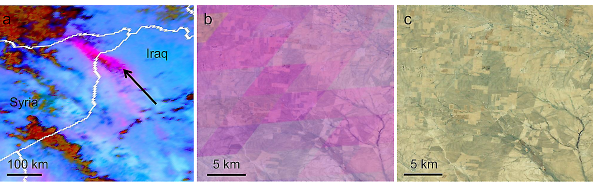
Fig. 12. (a) Dust plume over the eastern Algeria on 7 March 2010 and obscuration of dust sources located further north by clouds (dark red-brown). Black rectangle indicates area shown in (b) and (c) . (b) Colour enhancement on the SEVIRI image by the underly- ing surface, blue rectangle shows sources of dust, black rectangle shows colour enhancement by dark-coloured rocks. (c) True-colour surface reflectance image indicating location of dark-coloured rocks with no potential dust sources.